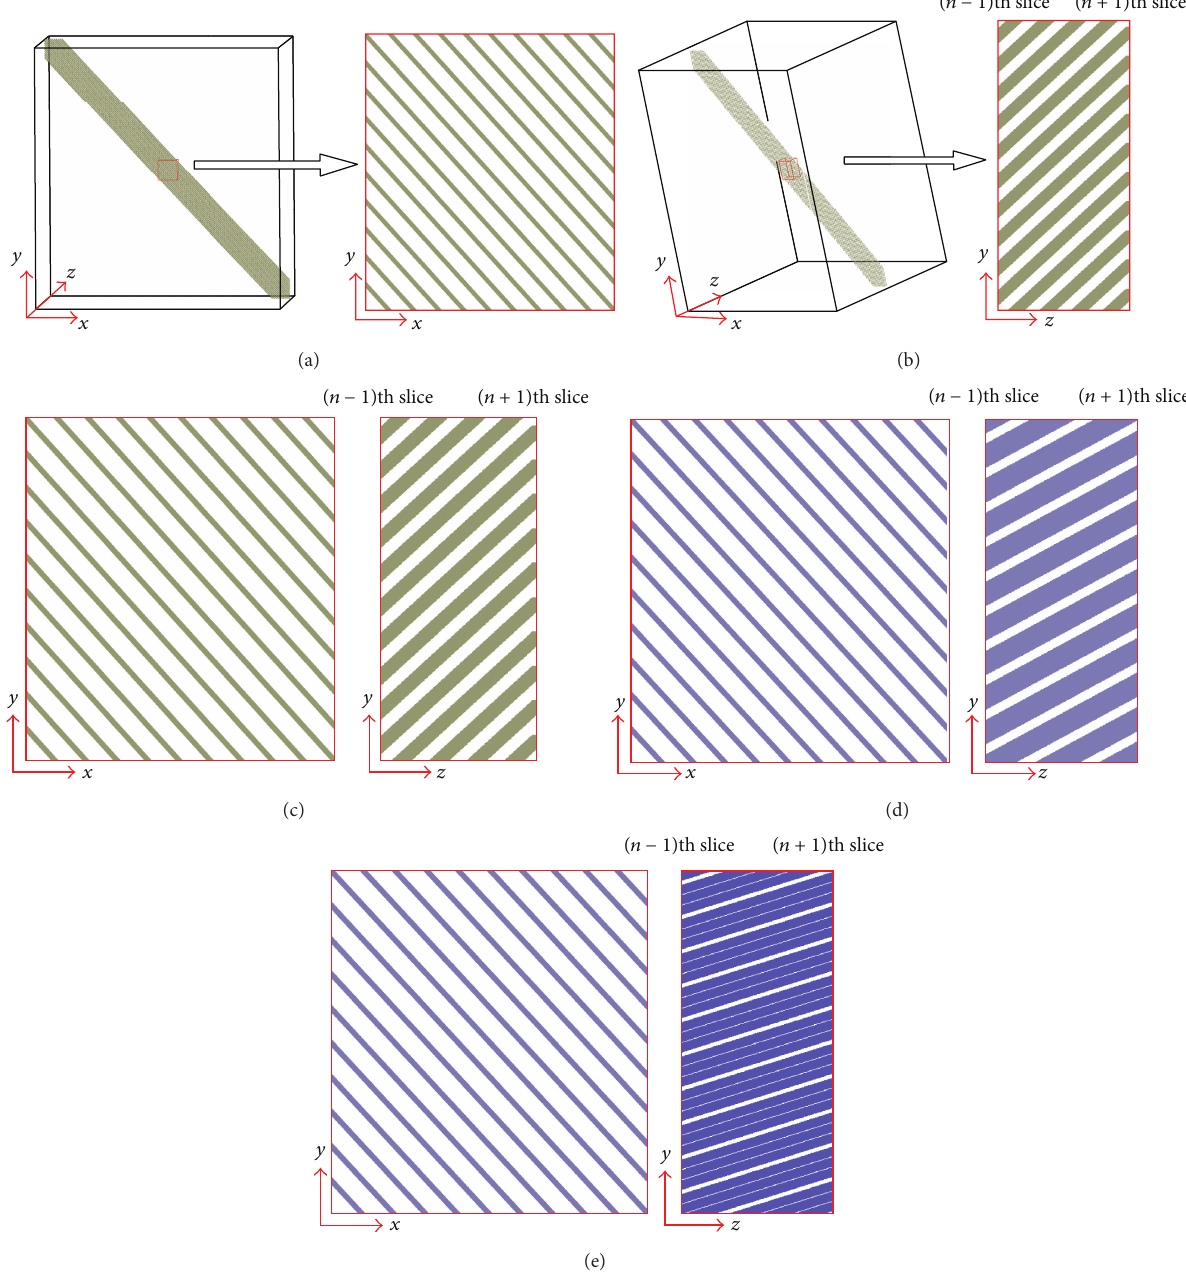
Figure 5: Synthesized data 𝐴 𝐼 , 𝐴 𝐼𝐼 , and 𝐴 𝐼𝐼𝐼 given in (10), (11), and (12): (a) three-dimensional representation of 𝐴 𝐼 and its projection to xy -plane, (b) another three-dimensional representation of 𝐴 𝐼 and its projection to yz -plane, and resulting two-dimensional representation of the synthetic data (c) 𝐴 𝐼 , (d) 𝐴 𝐼𝐼 , and (e) 𝐴 𝐼𝐼𝐼